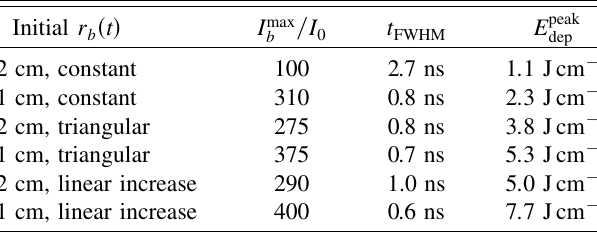
TABLE VI. Compression dependence on initial r using a 150 kG